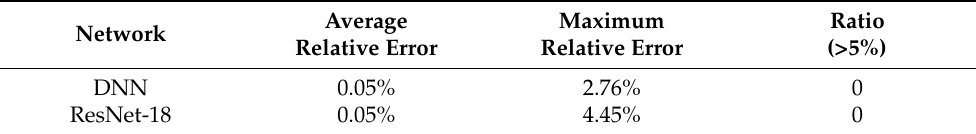
Table 6. The predictive performance of different neural networks on the total capacitance. Network Average Relative Error